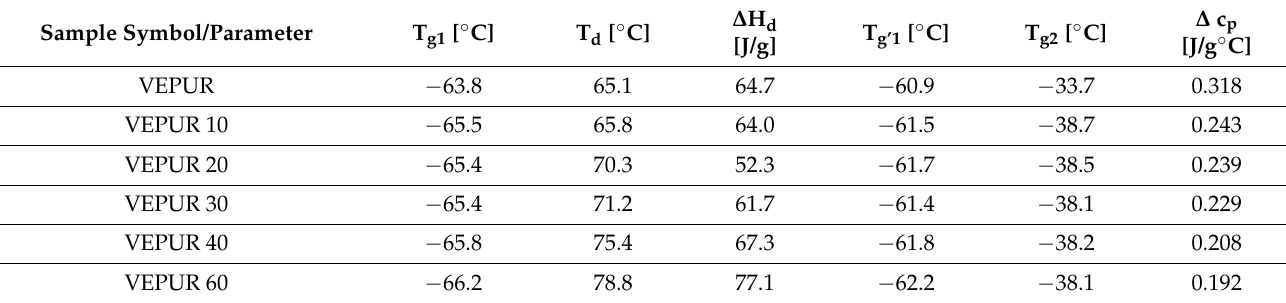
Table 9. Results of the DSC analysis of the examined materials.